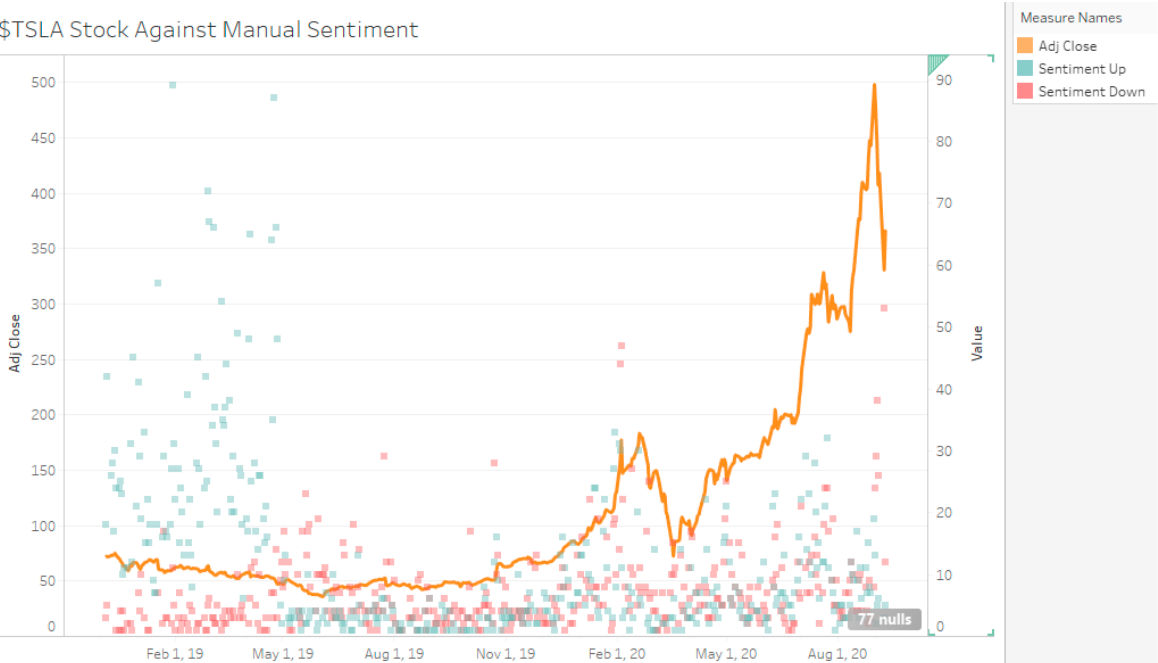
Sci 2023 , 5 , x FOR PEER REVIEW Figure 3. TSLA Stock Against Manual Sentiment. Figure 3. TSLA Stock Against Manual Sentiment.